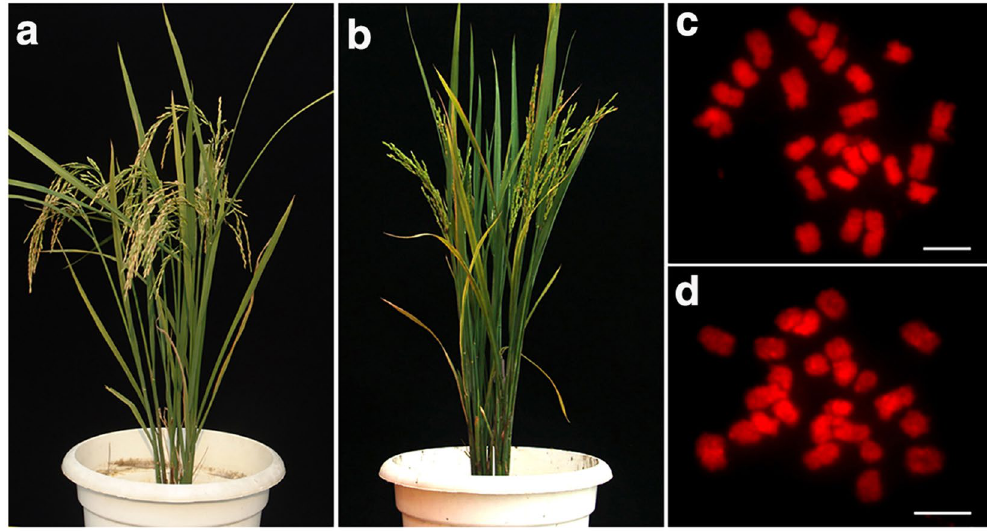
Figure 1. Morphological traits of rice line Zhongxian 3037 and variant YZG-5. ( a ) Zhongxian 3037. ( b ) Variant YZG-5 exhibits deep green leaf color and poor seed setting. ( c ) Zhongxian 3037 has 24 chromosomes in each somatic cell. ( d ) YZG-5 has 25 chromosomes in each somatic